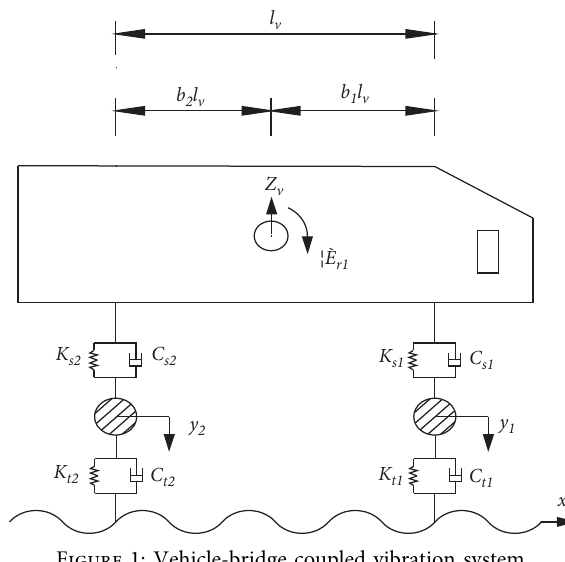
Figure 1: Vehicle-bridge coupled vibration system.